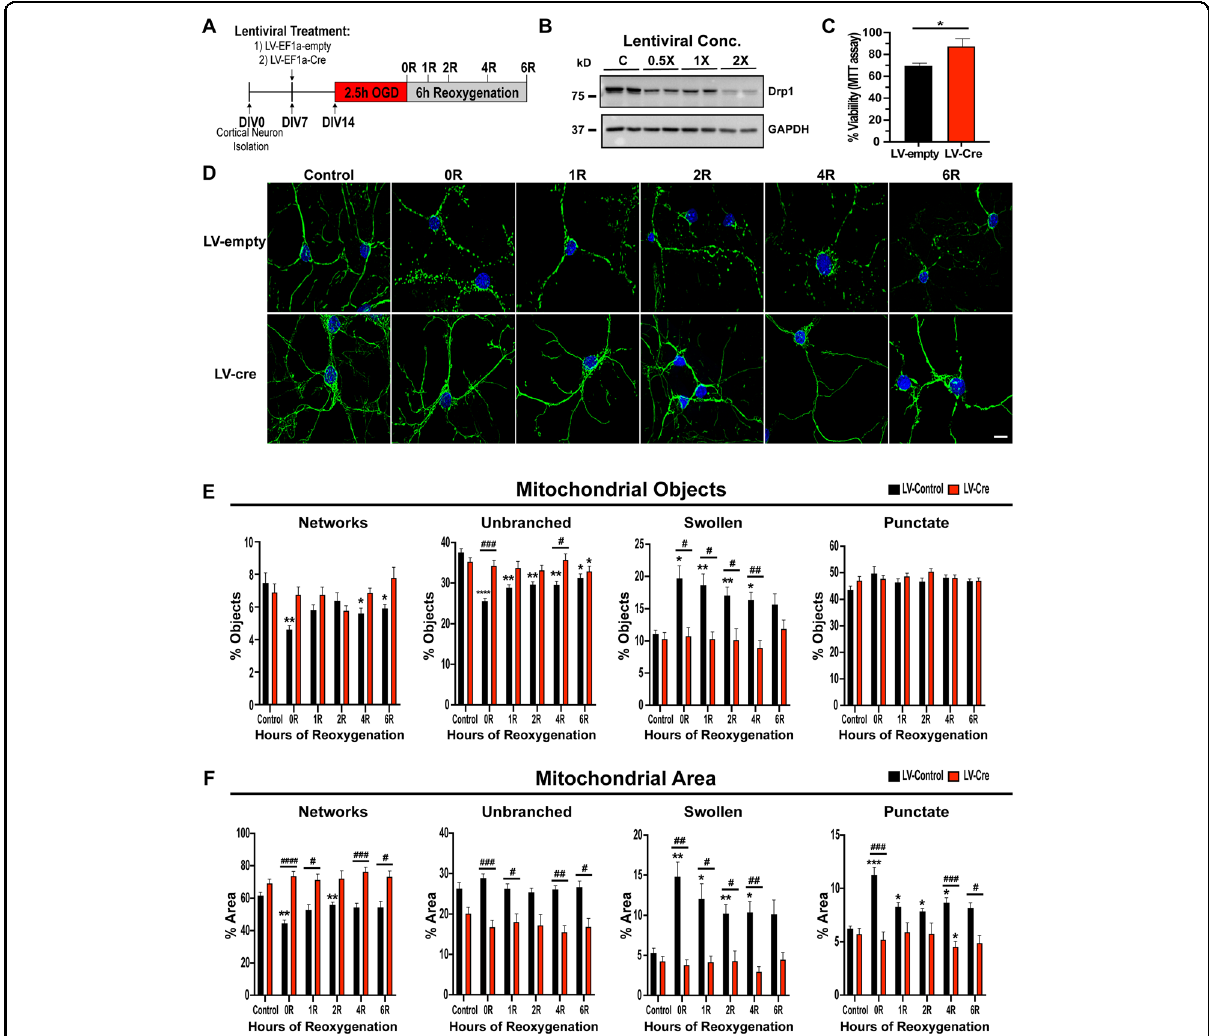
Fig. 4 Drp1 KO stabilizes mitochondrial morphology during OGD/R. A Schematic diagram of experimental design. B Western blot of Drp1 knockout after Lentiviral transduction in Drp1 fl / fl cortical neurons. C Viability of Drp1 fl / fl cortical neurons after 2.5 h OGD and 6 h reoxygenation (R). Comparison was made by Student ’ s t -test, n = 10. D Representative images of Drp1 fl / fl / QC Ki/ + primary cortical neurons (GFP channel), infected with either LV-EF1a-empty or LV-EF1a-cre, and subjected to OGD/R. E Individual comparisons of percent mitochondrial objects for each morphology over OGD/R. F Individual comparisons of percent mitochondrial area for each morphology over OGD/R. Two-way ANOVA was used to detect differences across time and between conditions. Multiple comparisons across time were assessed by comparing the means of each time point with the mean of the control and were calculated using Dunnett ’ s post-hoc analysis. Multiple comparisons between conditions were computed using Sidak ’ s post-hoc analysis. * p < 0.05; ** p < 0.01; *** p < 0.001; **** p < 0.0001 across time, # p < 0.05; ## p < 0.01; ### p < 0.001; #### p < 0.0001 between condition, n = 8 biological replicates per group. Scale bar = 10